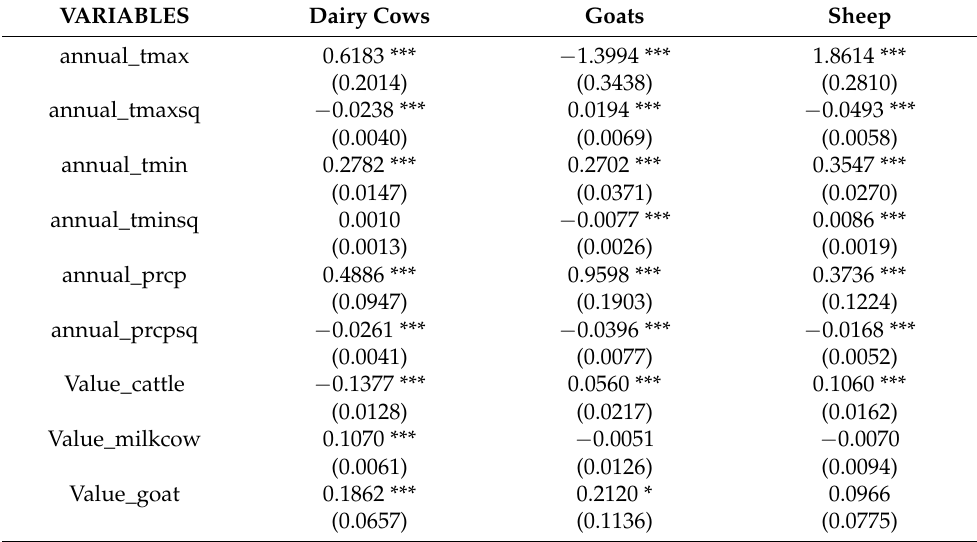
Table A1. Estimation results for livestock land use share in the east.